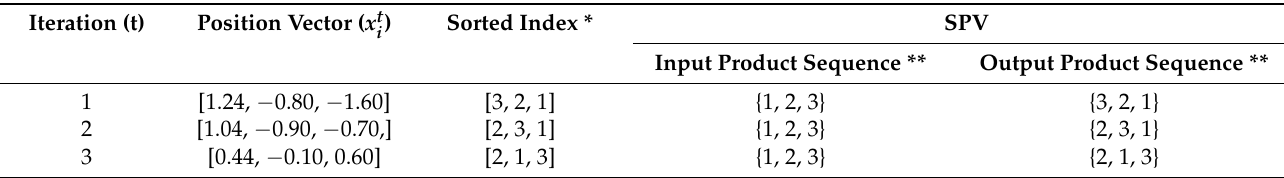
Table 3. Numerical explanation of converting a position vector into a production sequence using the smallest position value (SPV)